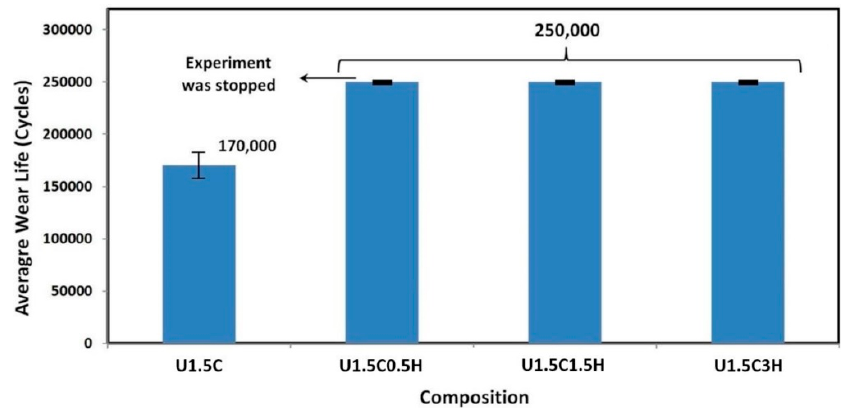
Figure 9. Average wear life of hybrid nanocomposite coatings, recorded after a wear test conducted at a normal load of 12 N, and a sliding velocity of 0.1 m/s for 250,000 cycles.